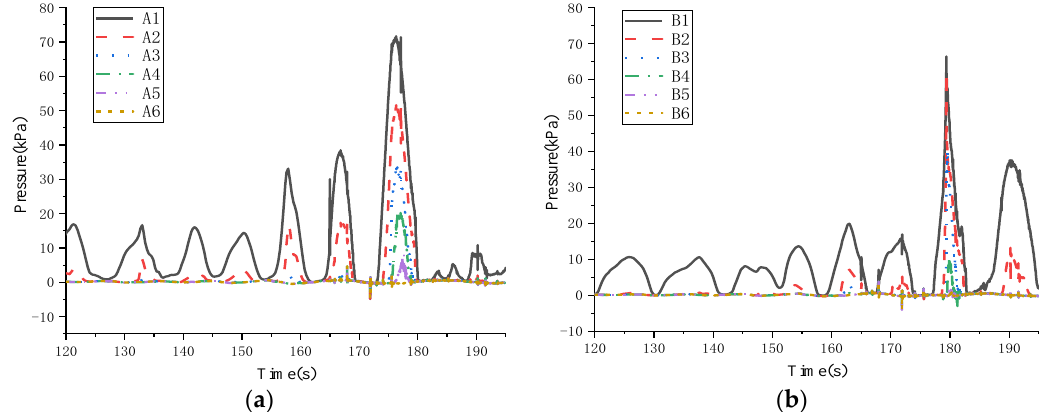
Figure 16. Pressure time series of column monitoring points. ( a ) The monitoring points of A1 – A6. ( b ) The monitoring points of B1 – B6.